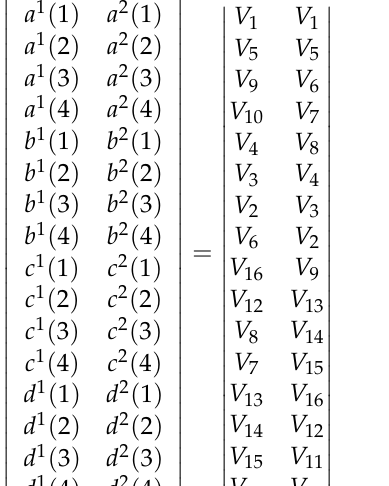
Figure 3. The used L-tetrolet patterns. Each L-tetrolet is named using a letter (e.g., a, b, c, d), and these letters are shown using different colors. These patterns are called P1 and P2. Step 2.4: Extract bits using P1, P2, and binary feature generation function 𝑆(. , . ) .